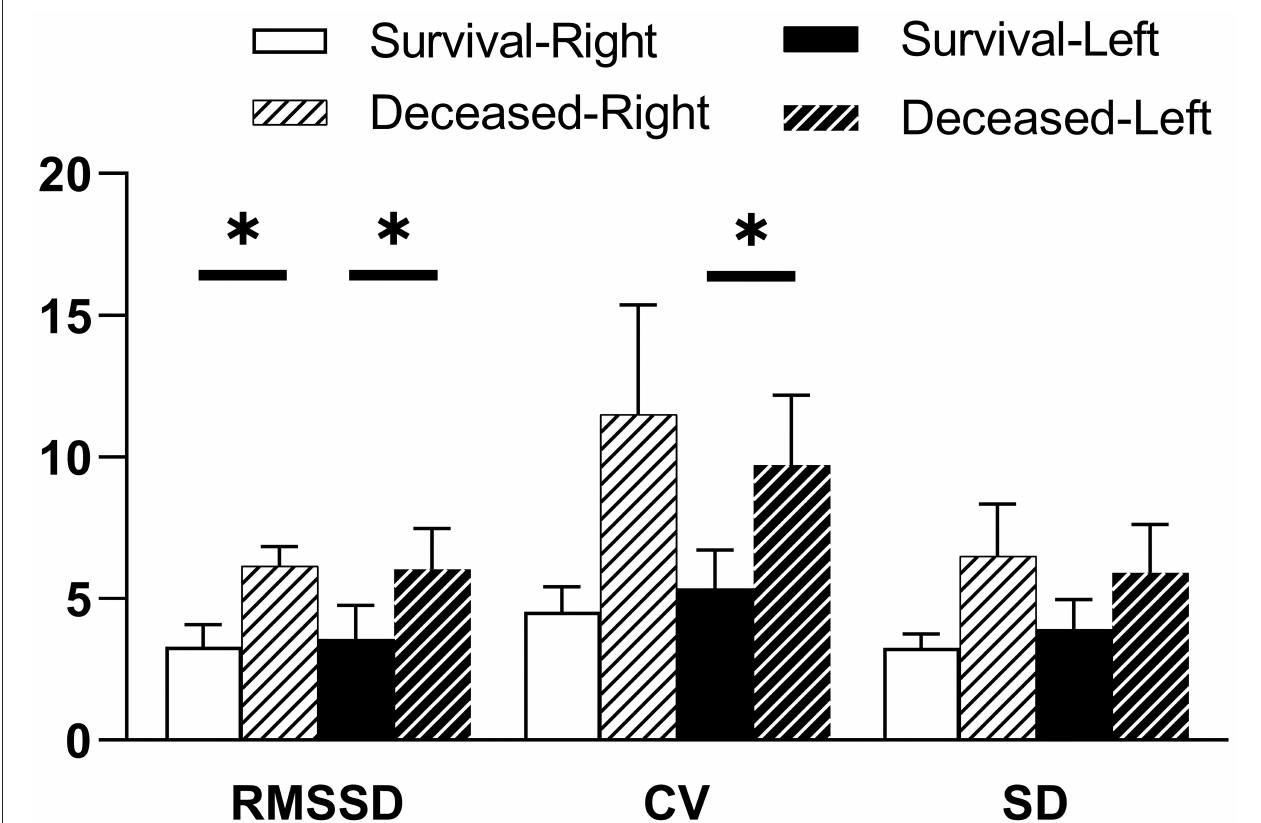
FIGURE 3 | CrSO 2 variability for the first 5 days following ECMO initiation according to PICU mortality. Indicators of CrSO 2 variability are RMSSD, root mean of successive squared differences; CV, coefficient of variation; SD, standard deviation. Results of the Student t -test indicate significant differences between survivors and non-survivors for right RMSSD, left RMSSD, and left CV, respectively. * p <